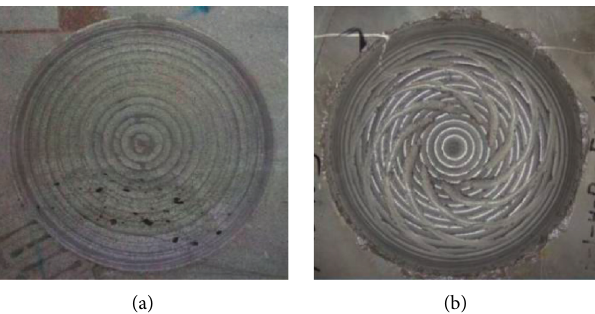
Figure 20: Bottom-hole patterns of a different bit. (a) Conventional PDC bit. (b) Cross-cutting PDC